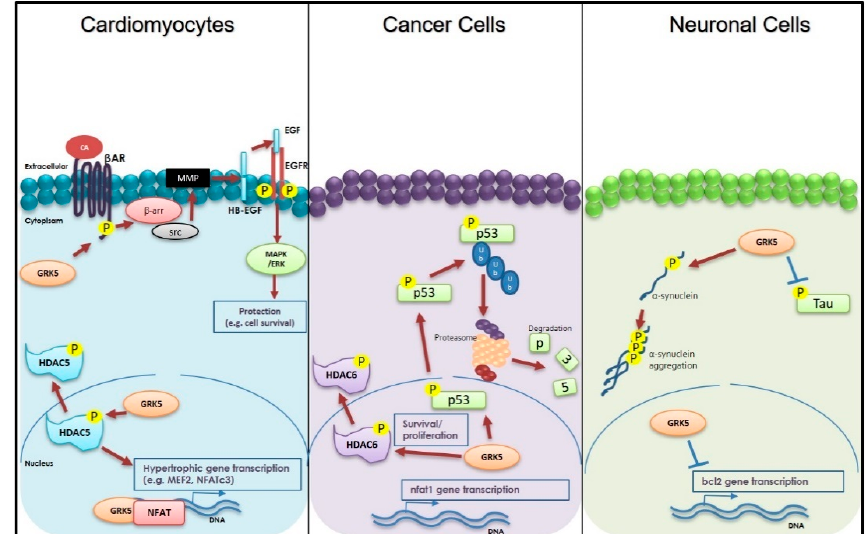
Figure 2. Schematic representation of G protein-coupled receptor (GPCR) kinase 5 (GRK5) activities within cardiomyocytes, cancer, and neuronal cells. In cardiomyocytes: GRK5 is involved in phosphorylation of GPCRs, including the β -adrenergic receptor ( β AR). Importantly, following catecholamine (CA) stimulation of β AR, GRK5 is also able to induce the transactivation of the epidermal growth factor (EGF) receptor (EGFR) via β -arrestin ( β -arr)/src/matrix metalloproteinases (MMP) pathway activation. EGFR in turn activates a Mitogen-activated protein kinase (MAPK)/ extracellular-signal-regulated kinase (ERK) protective pathway. In the nuclei, GRK5 is able to either bind to and phosphorylate Histone deacetylase 5 (HDAC5) or bind the DNA and Nuclear factor of activated T-cells (NFAT), thus enhancing hypertrophic gene transcription. In cancer cells: GRK5 regulates p53 via direct phosphorylation and degradation. Moreover, into the nuclei, GRK5 can phosphorylate HDAC6 or can increase NFAT1 expression. In neuronal cells: GRK5 inhibits Tau phosphorylation. Conversely, this kinase can increase α -synuclein phosphorylation, promoting its aggregation. Finally, in the nucleus, GRK5 inhibits B-cell lymphoma 2 (bcl2) gene transcription, increasing the